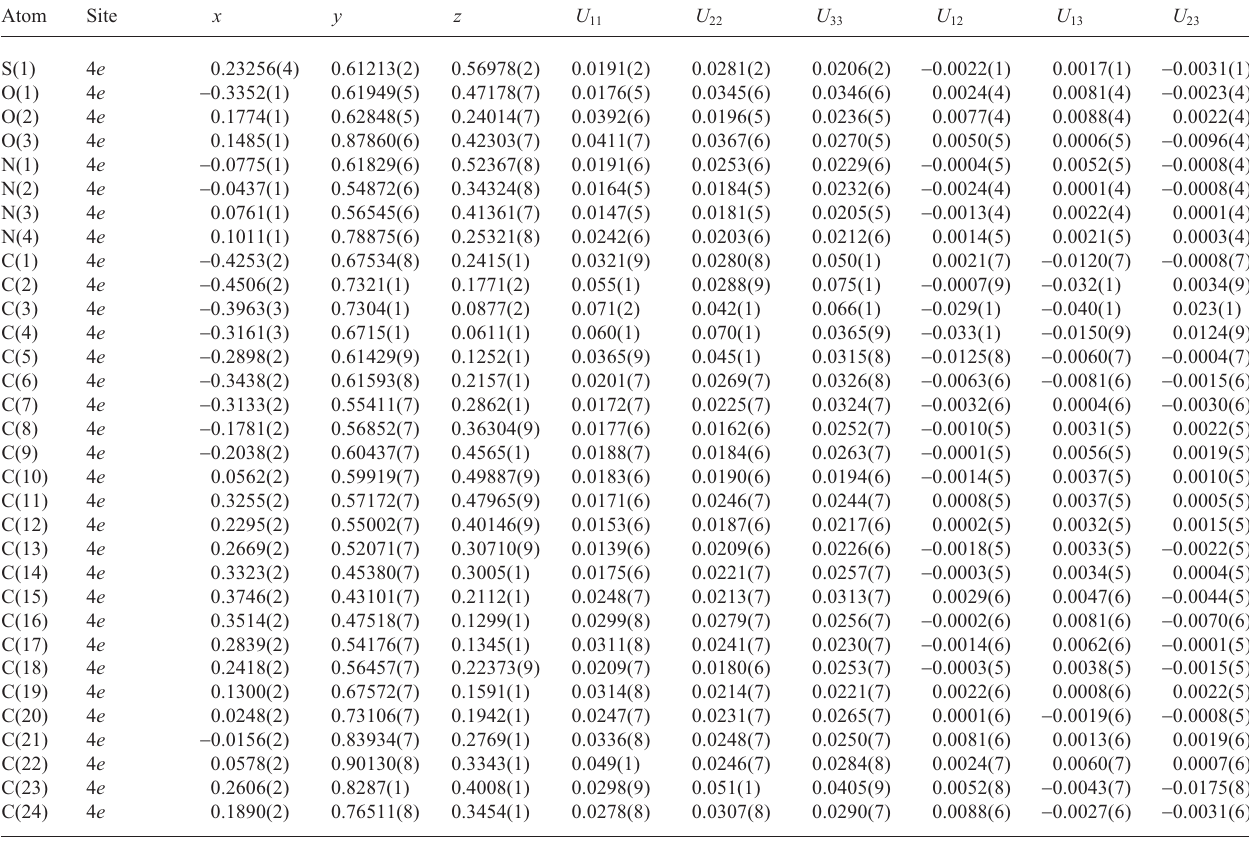
Table 3. Atomic coordinates and displacement parameters (in Å 2 )